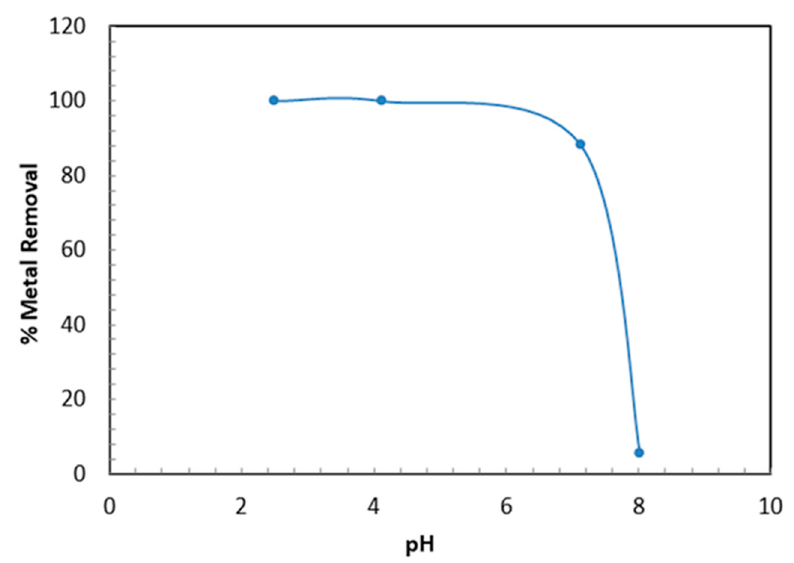
Figure 6. In fl uence of pH on the Cr (VI) removal by TBC-P.